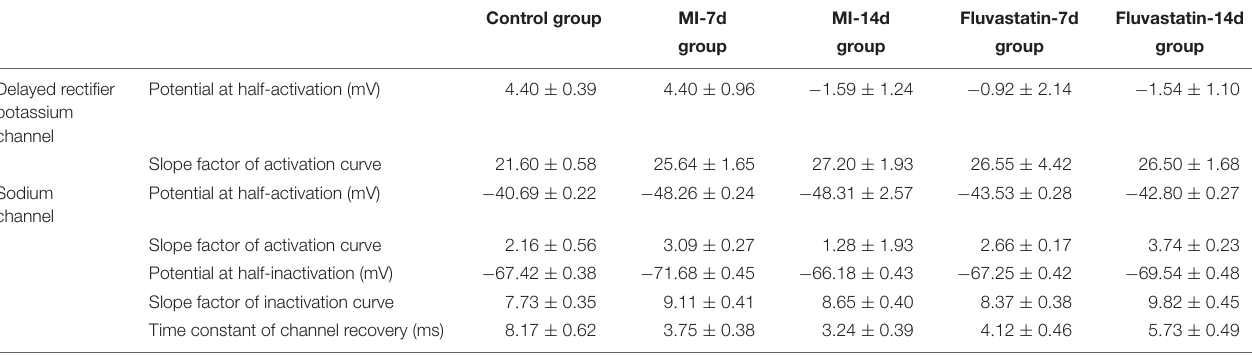
TABLE 1 | Parameters of delayed rectifier potassium channel and sodium channel in five groups. Control group MI-7d MI-14d Fluvastatin-7d Fluvastatin-14d group group group